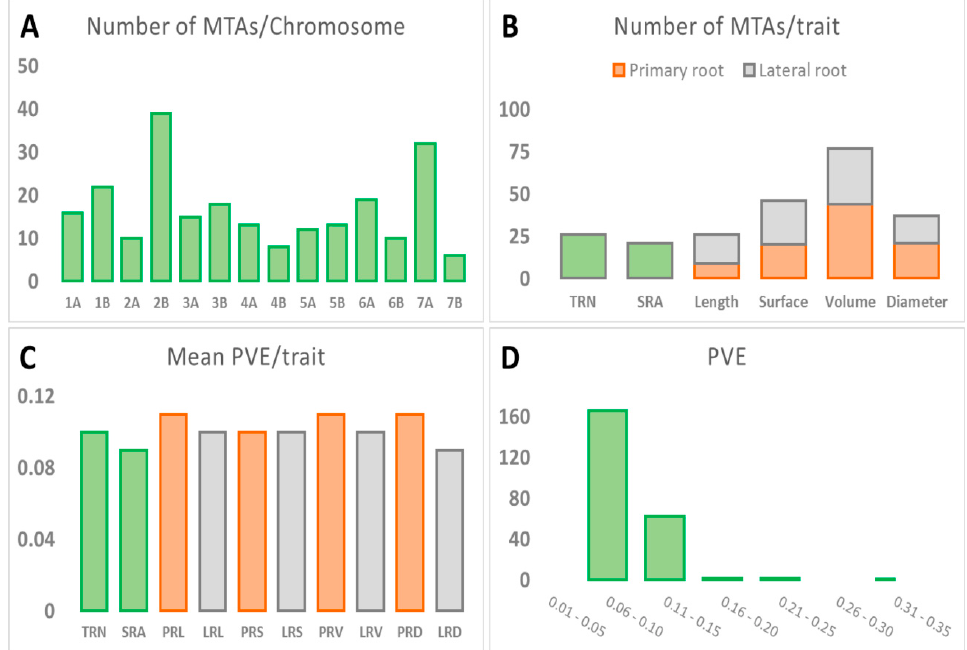
Figure 3. Summary of marker trait associations (MTA). ( A ) Number of MTAs per chromosome. ( B ) Number of MTAs per trait. ( C ) Mean PVE per trait. ( D ) PVE. TRN, total root number. SRA, seminal root angle. PRL, primary root length. LRL, total lateral root length. PRS, primary root surface. LRS, total lateral root surface. PRV, primary root volume. LRV, total lateral root volume. PRD, primary root diameter. LRD, mean lateral root